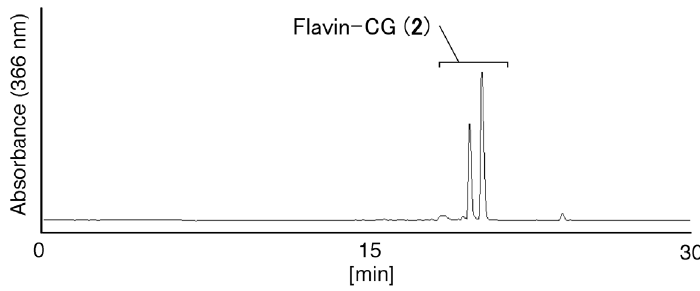
Figure 1. Analysis of flavin-CG ( 2 ). The sample was analyzed by HPLC using a Nacalai Tesque 5C18-ARII column (5 μ m, 150 × 4.6 mm) eluted using a solvent of 10 mM TEAA (pH 7), 25%–35% CH CN/20 min, at a flow rate of 1.0 mL/min and monitored by 3 absorbance at 366 nm.